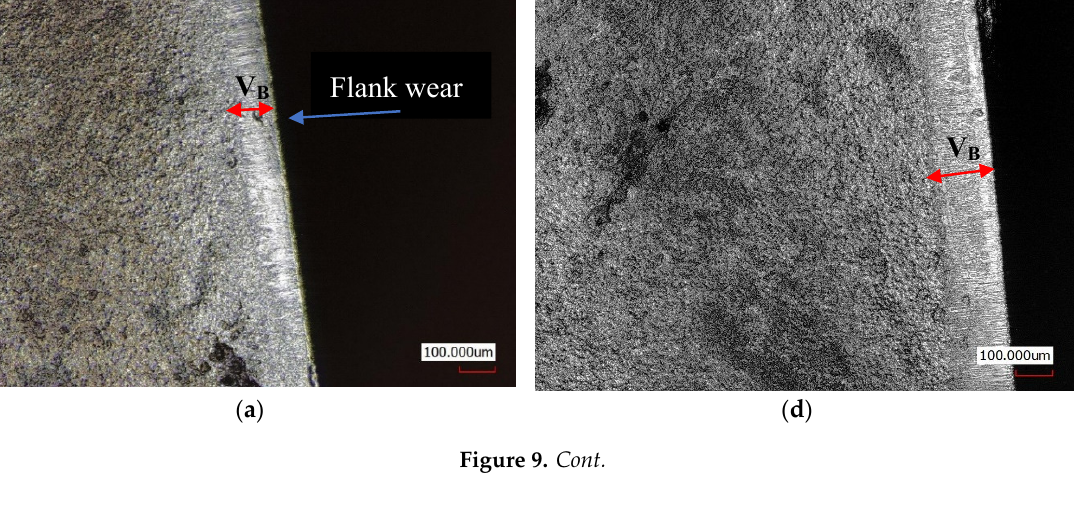
Figure 8. Boundary of worn zone: ( a ) W–B coating, ( b ) W–Ti–B coating.